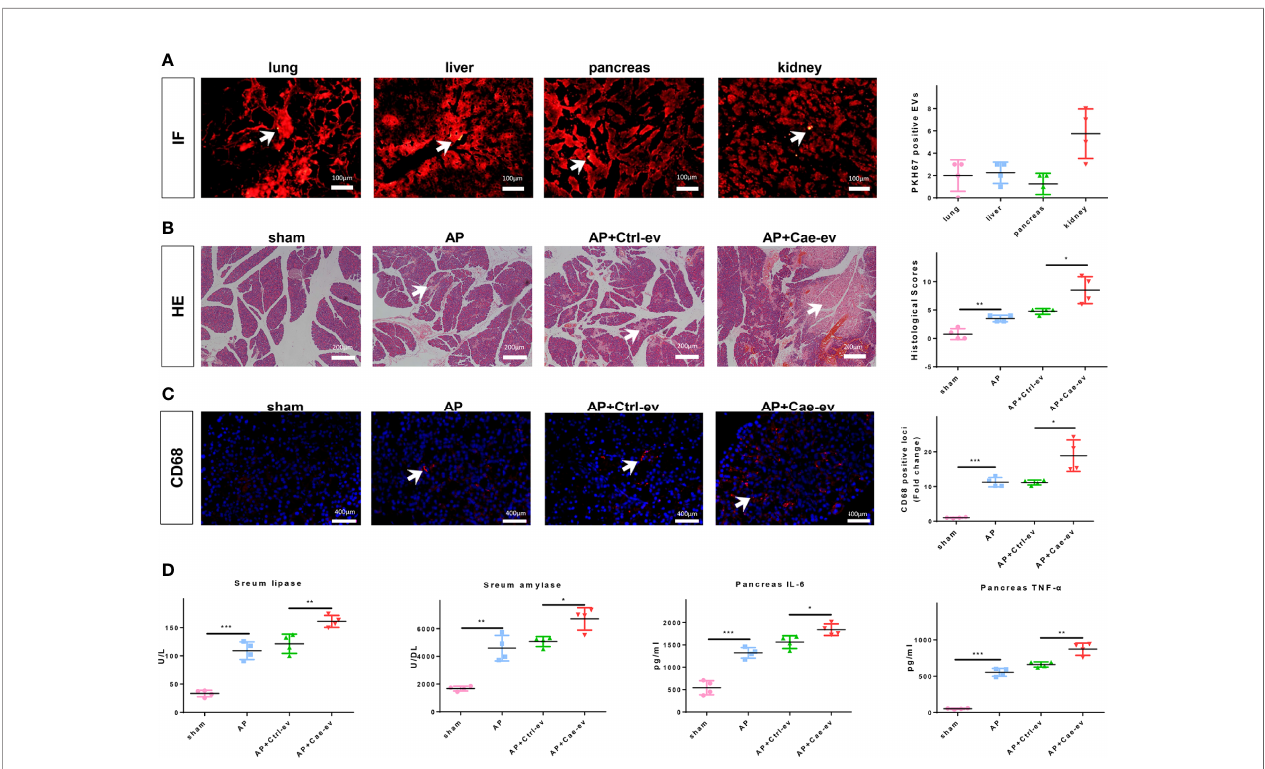
FIGURE 1 | EVs from caerulein-treated ACs aggravate AP. (A) Photographs of IF-stained sections of AP rat lung, liver, pancreas, and kidney samples harvested 6 h after EV injection. The number of PKH67-labeled EVs in the same fi eld of view from the four groups was determined. EVs are labeled with white arrows. Scale bar, 100 m m. (B) Representative photographs and histological scores of HE-stained pancreatic sections harvested from the rats in the 4 groups at 6 h after EV injection: sham, AP, AP+Ctrl-ev and AP+Cae-ev groups. Pancreatic injury is indicated by the white arrows. Scale bar, 200 m m. (C) Microscopy images of the distribution